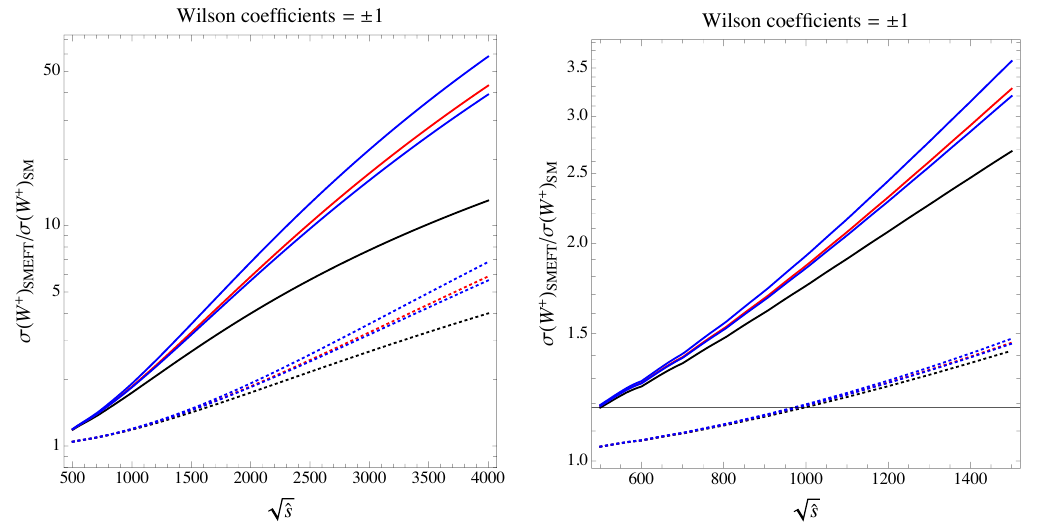
√ ˆ s calculated in SMEFT compared to the SM Figure 1 . Differential cross section dσ ( pp → ‘ + ν ) /d √ value as a function of ˆ s , with all Wilson coefficients set to a magnitude of 1 and a new physics scale of 5 TeV for the solid curves and 10 TeV for the dotted curves. The black lines show the ratio with the SMEFT calculation truncated at O ( x ) = O (1 / Λ 2 ) while the red and blue curves show the ratio using the full O ( x 2 ) SMEFT result. The red line shows the effect when we take all dimension eight coefficients to be positive, and the blue lines enveloping the red line show the result where we choose the signs of C s, 3 , (8) and C t, 3 , (8) LQ